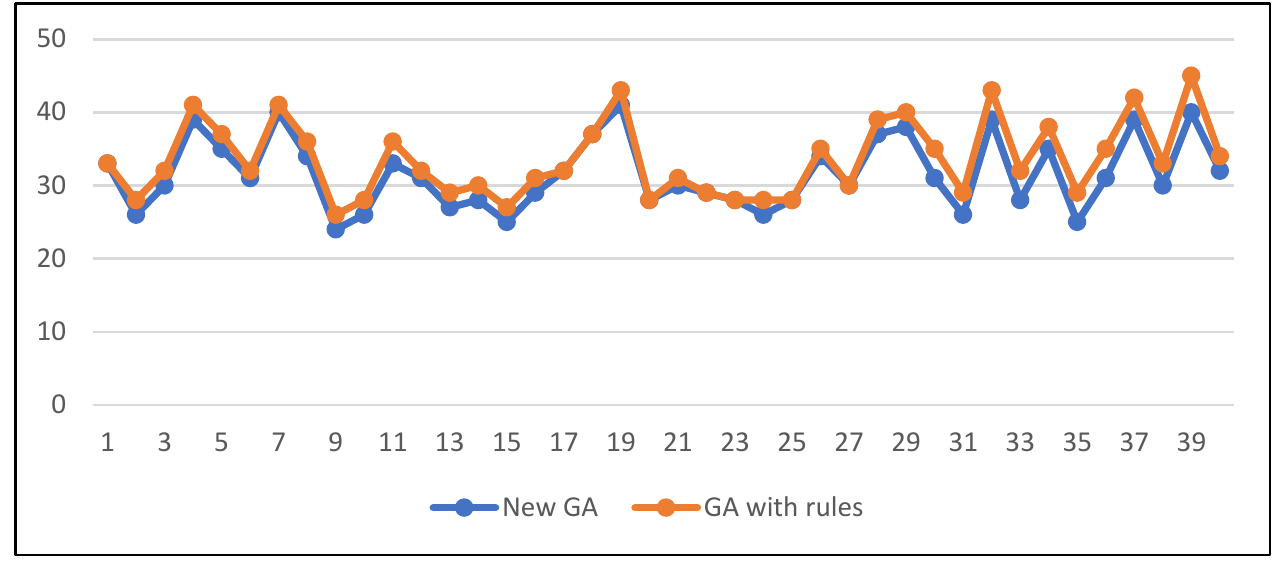
Figure 14. A comparison of the results of method GA with rules and our new method for all 40 instances of the test set for bay size 6 × 7.